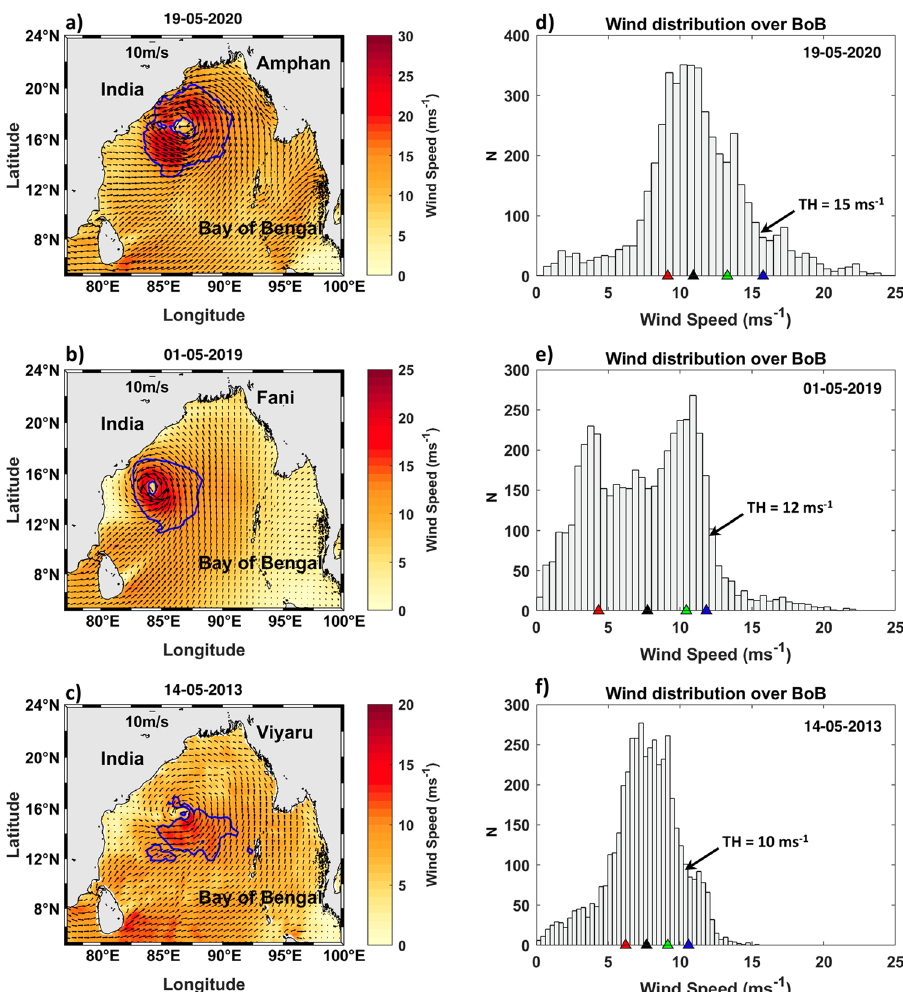
Figure 6. Wind speed (shaded color, ms −1 ) for ( a ) Amphan, ( b ) Fani and ( c ) Viyaru with wind directions. ◦ Histogram for wind speeds over the Bay of Bengal (4–24° N, 76–100 E) for three cyclones on selected days. Red, black, green, and blue dots indicate the 25th, 50th, 75th and 90th percentile. ‘N’ denotes the number of grid points. Blue contours on the left panels are for the threshold wind speeds (TH on the right) in ( a ) 15 m s −1 , ( b ) 12 m s −1 , and ( c ) 10 m s −1 . The relative strength of the three cyclones are visible in the wind field on the left as well as in their domain-wide distribution on the right. The maps (coastlines) are created with Matlab M_Map v1.4 toolbox (https:// www. eoas. ubc. ca/ ~rich/ map.